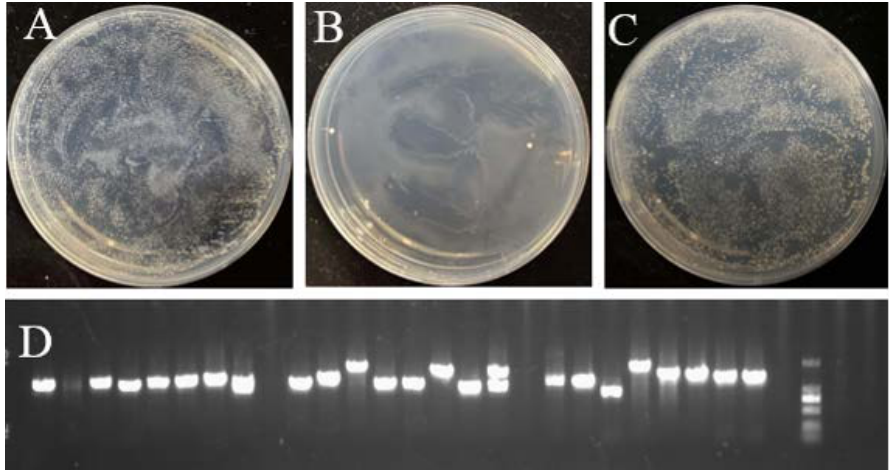
Figure 8. Screening of cDNA library of Citron C-05. ( A ) Y1HGold[pBait-AbAi] yeast cells